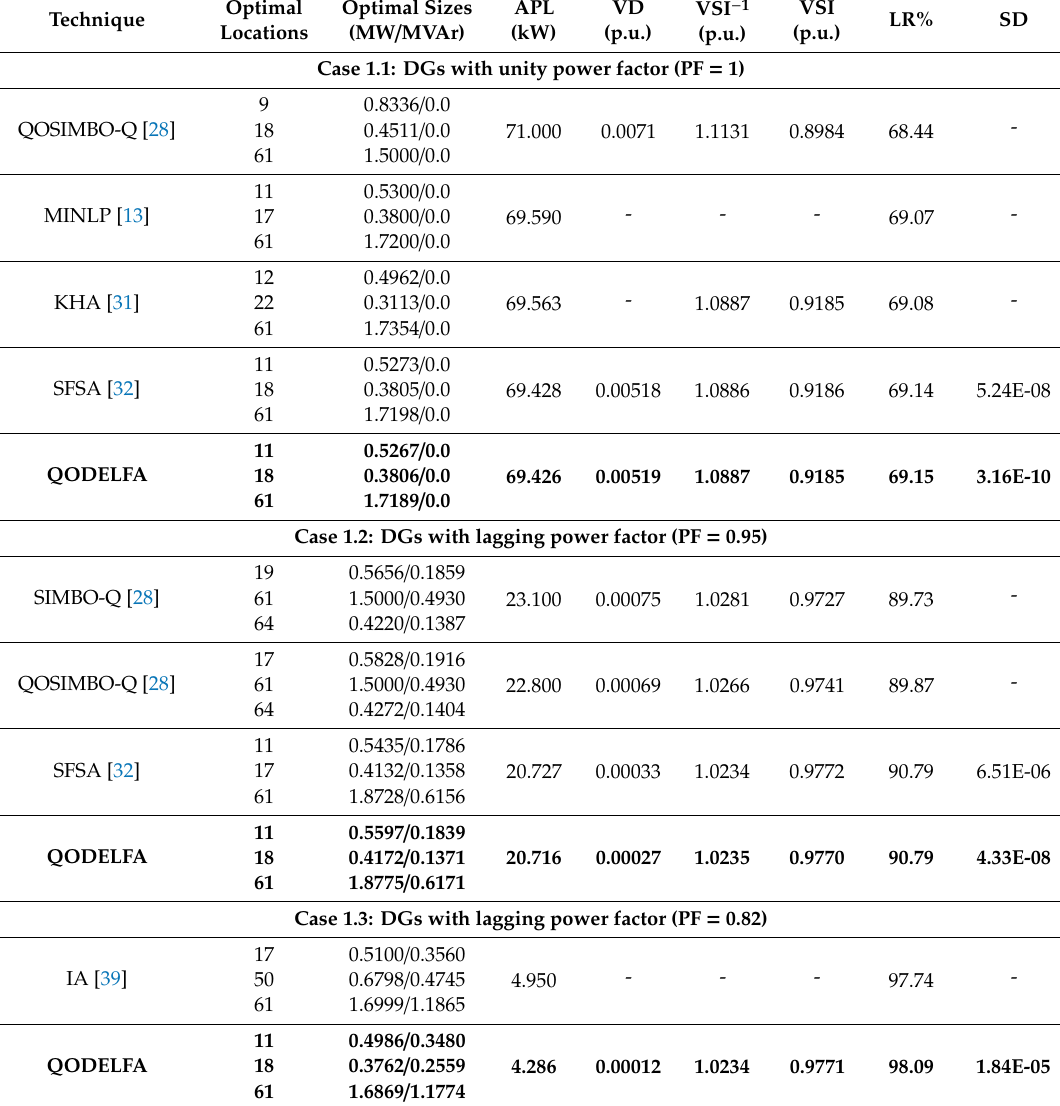
Table 6. Results for the IEEE 69-bus RDS with OF 1